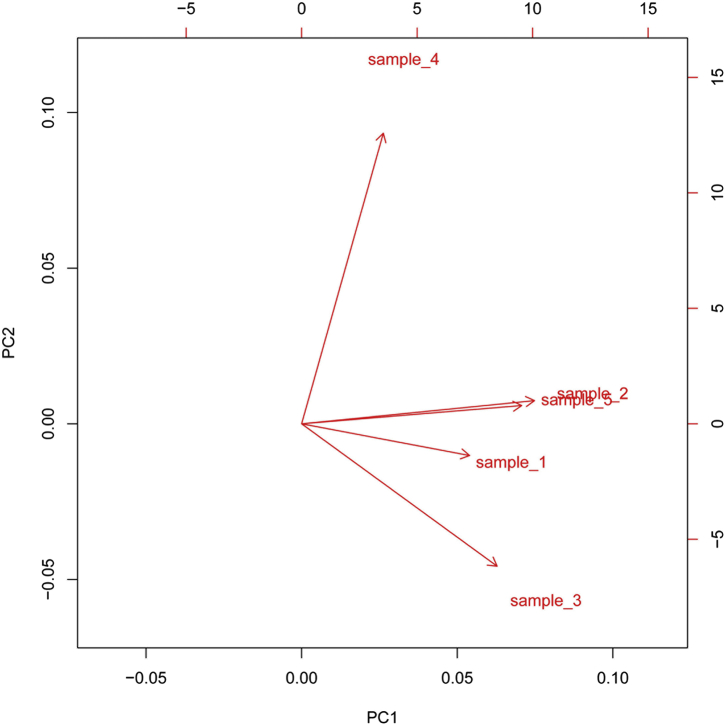
Principal component analysis and hierarchical clustering show that sample 4 was the most divergent, relative to the other 4 samples. PC = principal component.